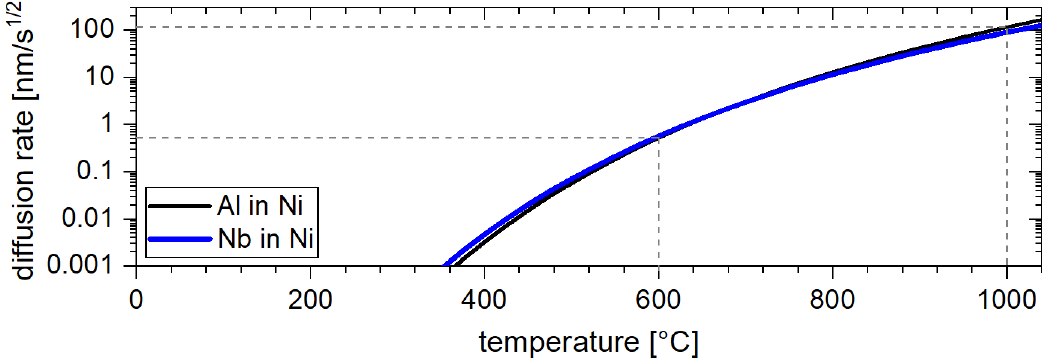
Figure 12. Calculated diffusion rate for aluminum and niobium in nickel. The diffusion rate was calculated by an Arrhenius equation and literature data for Al [40] and Nb [41] in Ni. Despite these experimental differences between the lab-source and synchrotron X-ray diffraction experiments, the γ (cid:48) dissolution process was very similar for both methods and was subdivided into different temperature